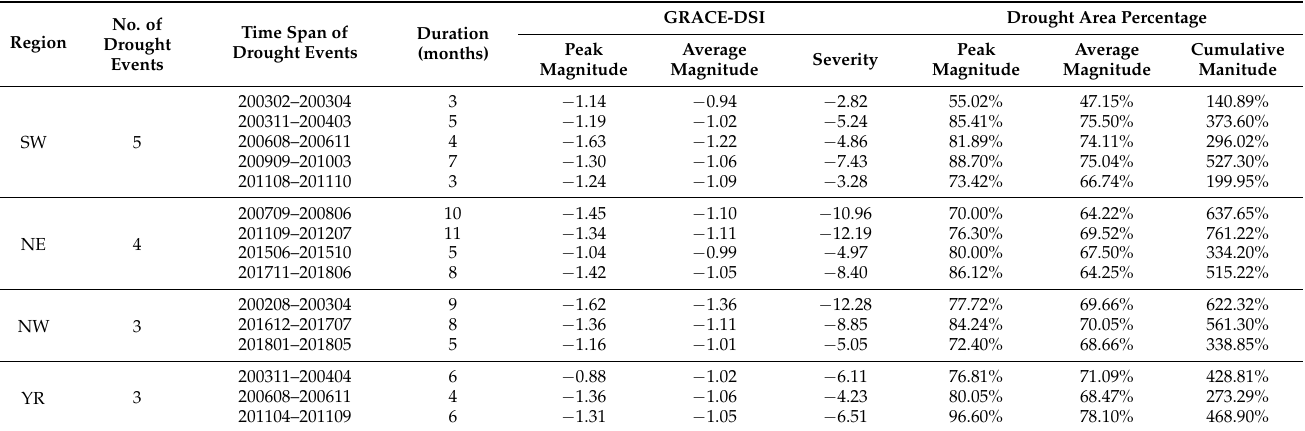
Figure 4. Drought events (drought duration, drought severity, and drought-affected area) in Mainland China during April 2002 and July 2020 (the red bars represent the drought severity, orange bars represent the drought area percentage). Table 3. Summary table of drought events identified by